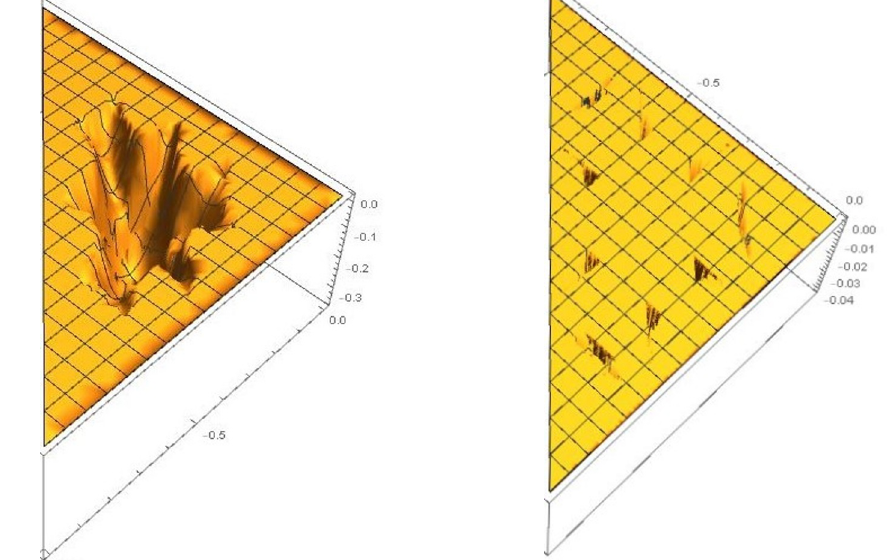
Figure 4. The di(cid:11)erence (scaled by a factor of 12) between the numerically maximized Q h , and the Q h maximized over the divisor con(cid:12)gurations x d , on the arg (cid:12) > 0 W wing, for N = 5 on the left, and for N = 6 on the right. When the result is zero, it means the divisor con(cid:12)gurations are maximizing Q h (hence minimizing V e(cid:11) ). Note the big hole in the middle for N = 5, and the small holes for N = 6, signalling the failure of the divisor con(cid:12)gurations to maximize Q h (hence to minimize V e(cid:11)